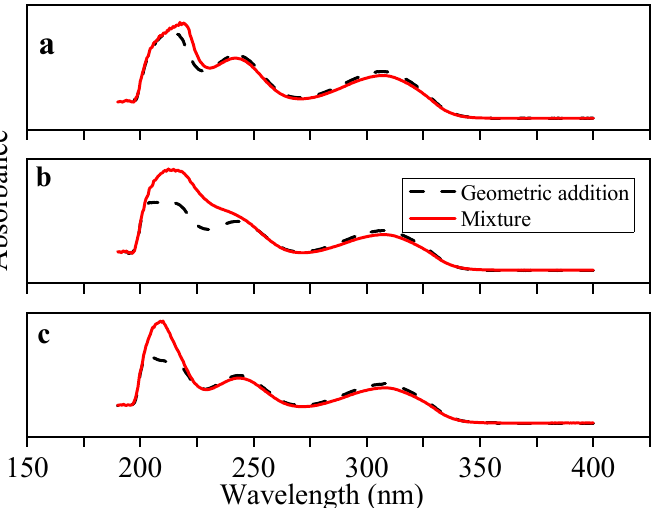
Figure 3. UV absorption spectra of CAP and host-guest coordination compound (( a ) CAP-4-VP, ( b ) CAP-AM, ( c ) CAP-MAA) in DMSO.